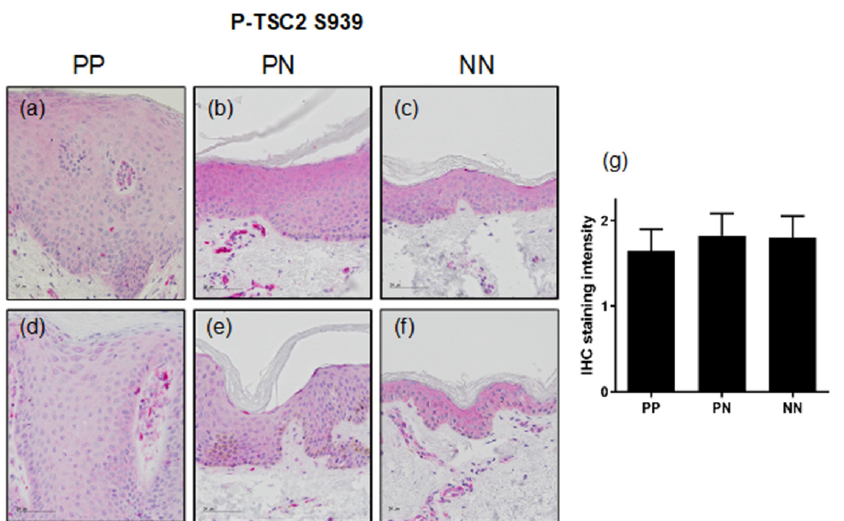
Figure 3. ( a – f ) IHC staining with TSC2-specific antibodies of two representative biopsies from le- sional (PP; a , d ) or non-lesional (PN; b , e ) skin of psoriasis vulgaris patients or healthy donors (NN; c , f ). Bars represent 50 μ m. ( g ) The graph represents the quantification of IHC staining intensities from 10 psoriasis patients and 3 healthy individuals (mean ± SEM). Statistical significance was cal- culated with one-way ANOVA and Fisher’s LSD test (* p < 0.05).